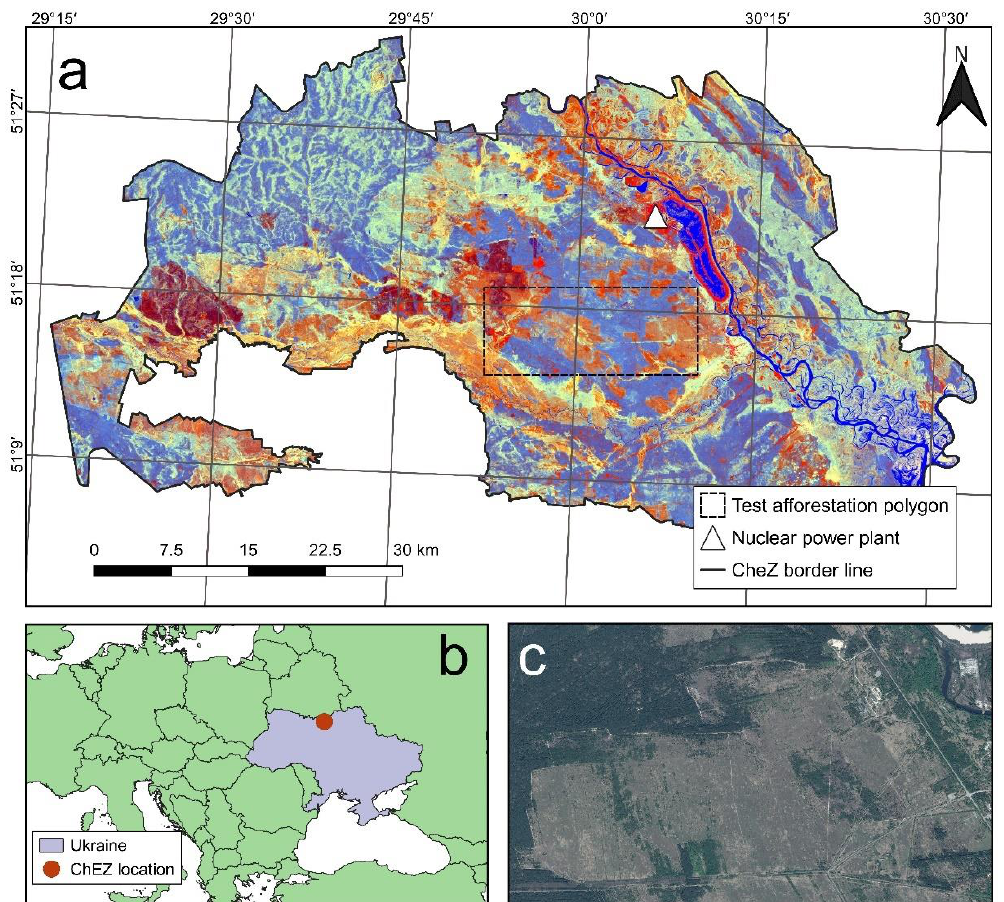
Figure 1. Study area: ( a ) the Chernobyl Exclusion Zone (ChEZ) overlaid with a false-color Tasseled Cap composite (TCB, TCG, TCW); ( b ) the location of the ChEZ in Europe; and ( c ) an example of a very high-resolution (2017) image from Google Earth for a test afforestation polygon.